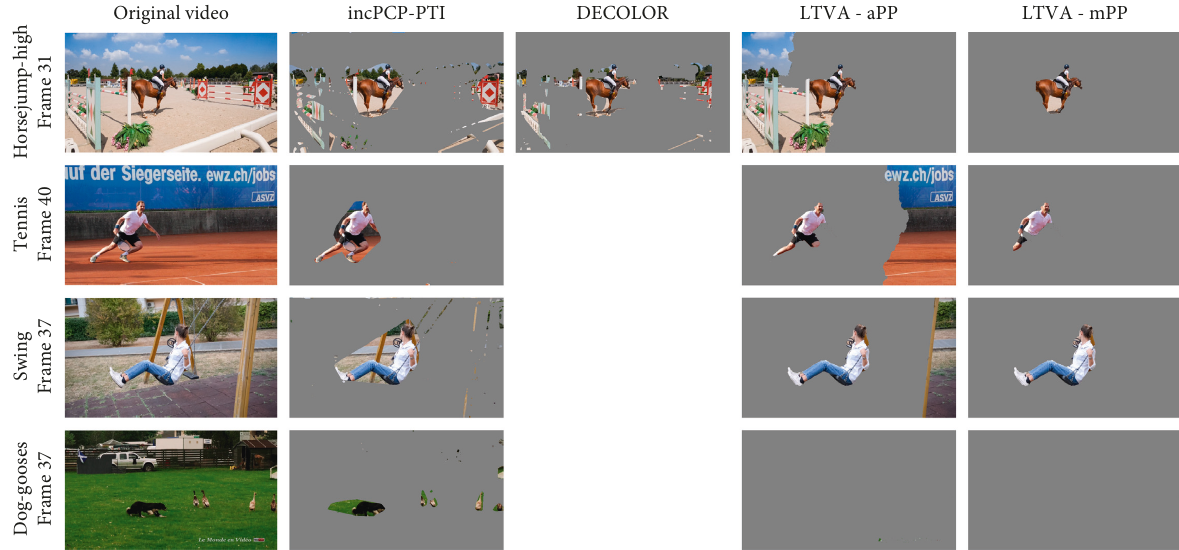
Figure 7: Selected frames from three sequences of the Davis dataset (Section 4.3) along with the segmented sparse components for incPCP- PTI, DECOLOR, and LTVA (aPP and mPP). The sequences in which DECOLOR did not work properly are left blank. Table 4: Average F measure performance of incPCP-PTI, DECOLOR, and LTVA on the DAVIS dataset sequences.